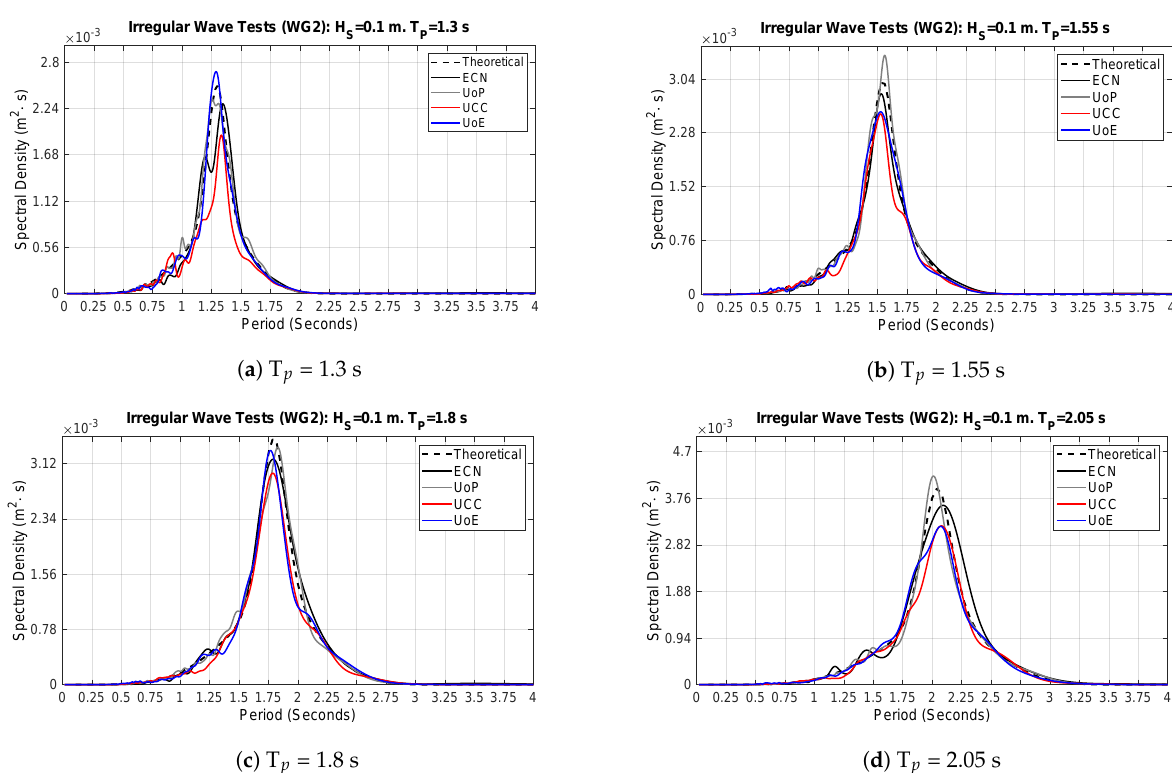
Figure 4. Wave spectra measured at the nominal model location (with the model absent) for a nominal H s of 0.1 m across